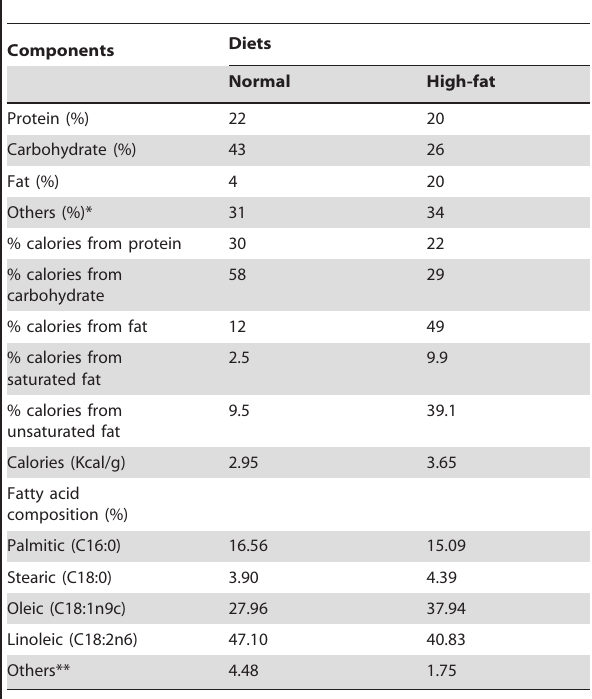
Table 1. The calorie composition of the experimental